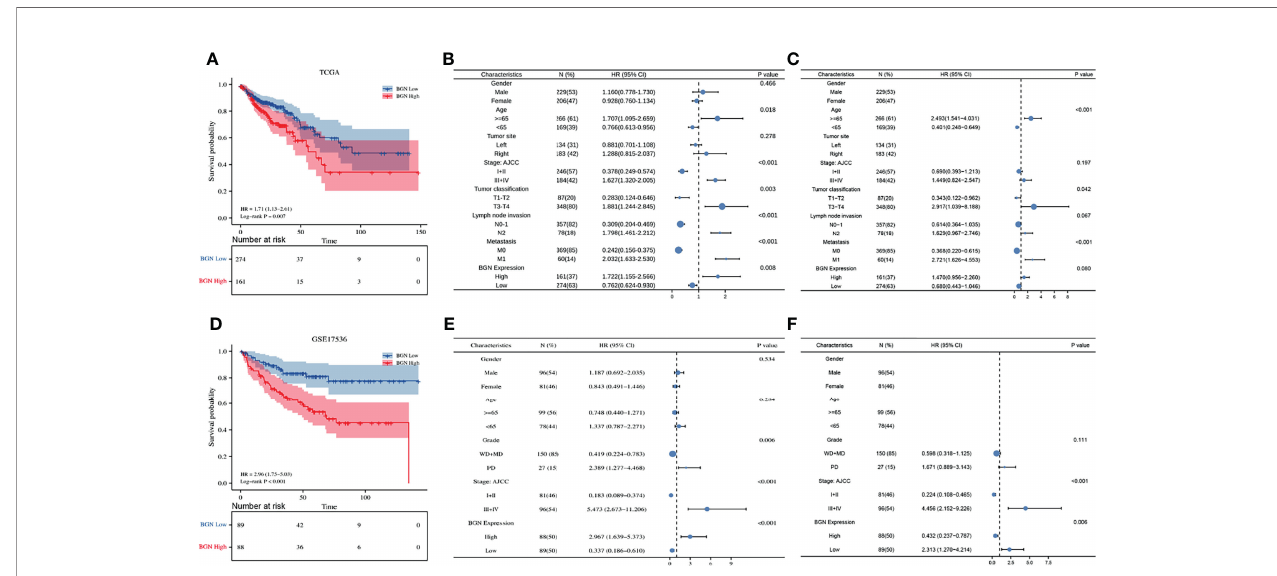
FIGURE 3 | The expression levels of BGN are correlated with overall survival and clinicopathological characteristics of colon cancer patients in TCGA and GSE17536 dataset. (A, D) Kaplan-Meier analysis of overall survival in colon cancer patients with different BGN expression. The signi fi cance was calculated by the Log-rank test. Number of patients remaining in follow-up at each time point is reported in the box below the fi gure for each group. (B, C) Univariate and multivariate cox regression analysis of clinicopathological characteristics and BGN expression with overall survival in TCGA. (E, F) Univariate and multivariate cox regression analysis of clinicopathological characteristics and BGN expression with overall survival in GSE17536. p<0.05 was considered statistically signi fi cant. Whiskers represent the 95% con fi dence interval of the HR value, and dots represents the values of HR.